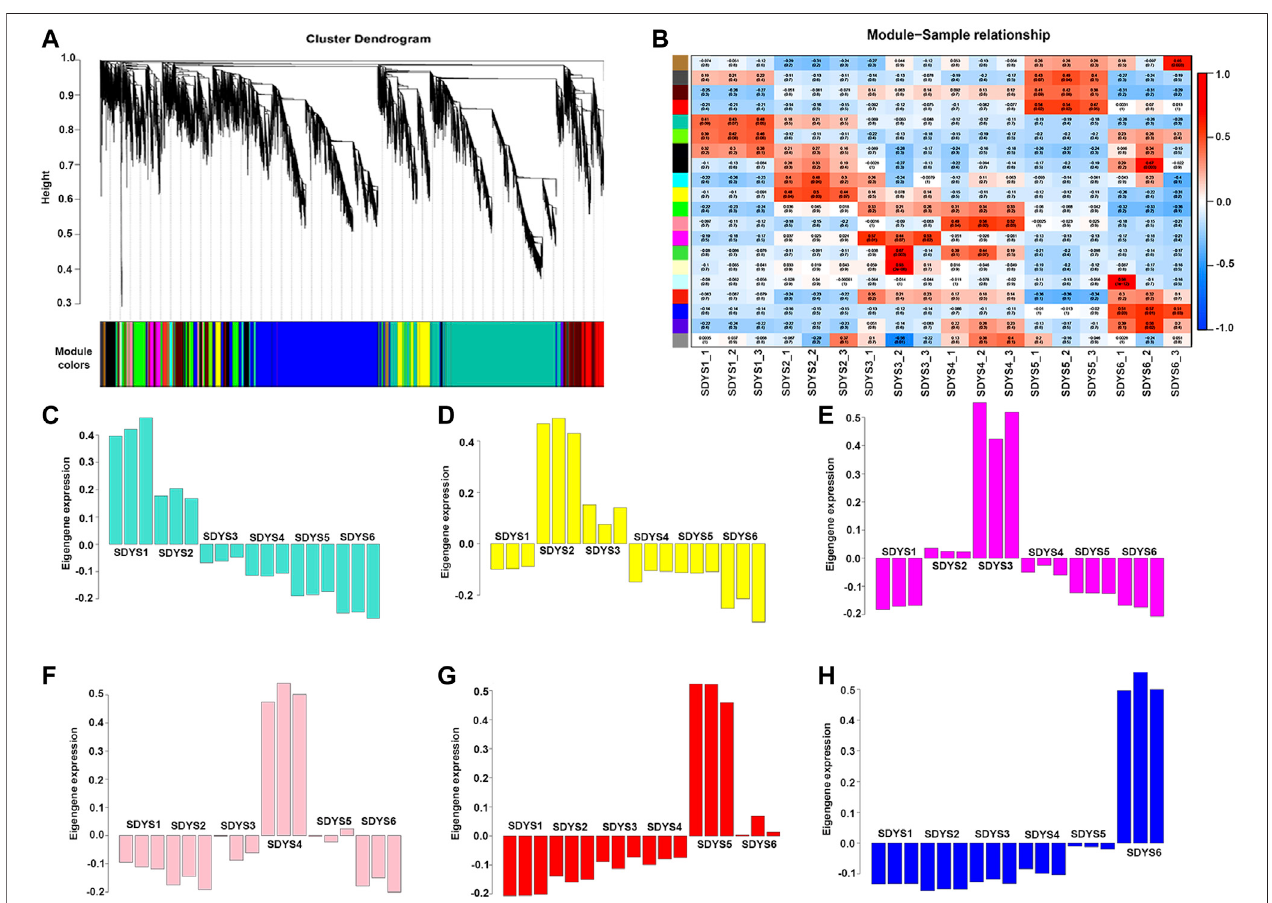
FIGURE 7 | Zygotic embryo development related module performed by WGCNA. (A) Cluster dendrogram of co-expressed genes. (B) Heat map of correlation between co-expression modules. (C – H) Correlation between co-expression modules and traits. A negative value represents a negative correlation, and a positive value represents a positive